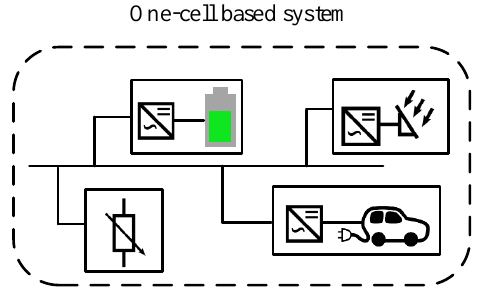
Figure 4. One-cell based